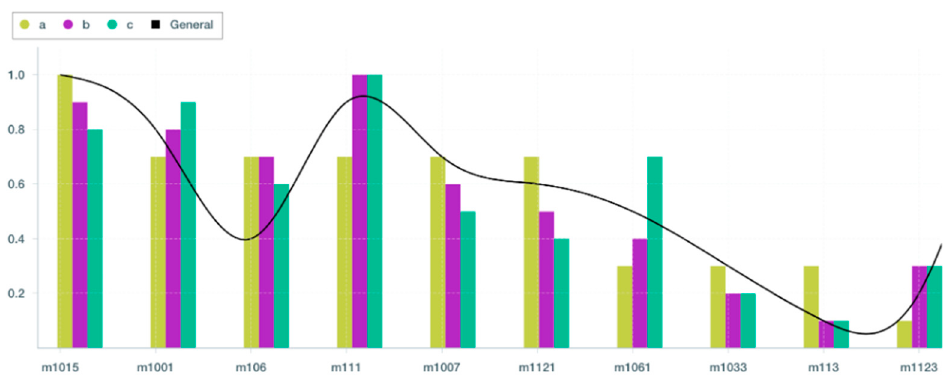
Figure 8. Rank of top resources selected for Task 318037 with varying weight preferences.